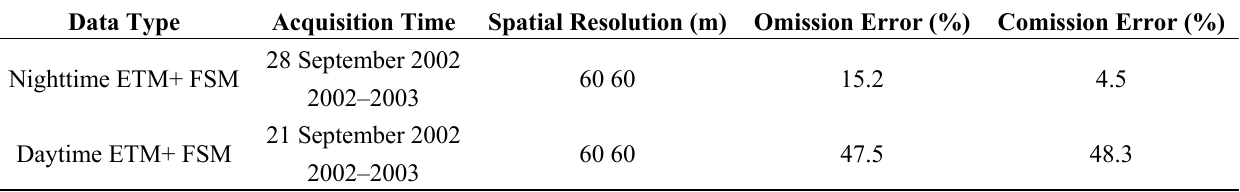
Table 5. Validation of results of coal fires from 2002 daytime satellite data and 2002 nighttime satellite data using coal fires map by field